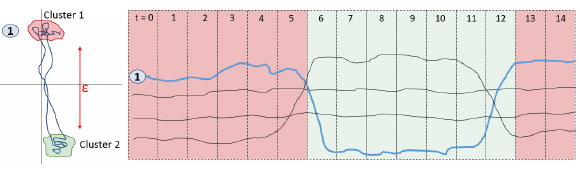
Figure 4. A clustering-based change detection method is applied to find intra-group position changes. Three resulting clusters (left) indicate that object 1 (blue) changes its position